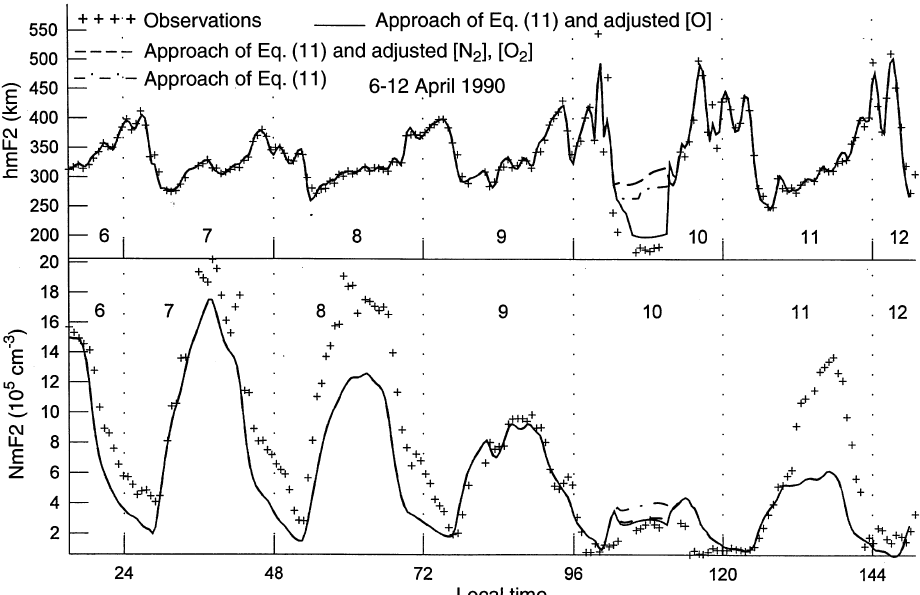
neutral atmosphere model. Solid and dashed lines show e(cid:128)ects of adjustments to the MSIS-86 model between 07:00 and 15:00 LT on 10 April at all altitudes. Solid lines shows results when the MSIS-86 model [O] was decreased by a factor 1.8. Dashed lines show results when the MSIS-86 model (cid:137) N 2 ] and (cid:137) O 2 ] were increased by a factor